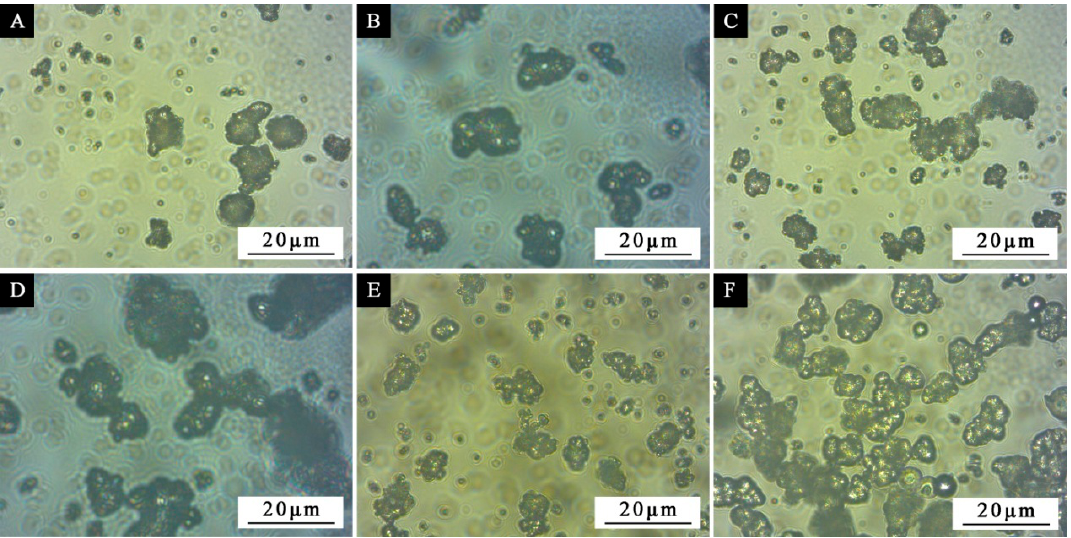
Figure 5. The optical microscopy morphologies of microcapsules prepared under different depositing time: ( A ) 0, ( B ) 1 d, ( C ) 2 d, ( D ) 3 d, ( E ) 4 d, ( F ) 5 d.